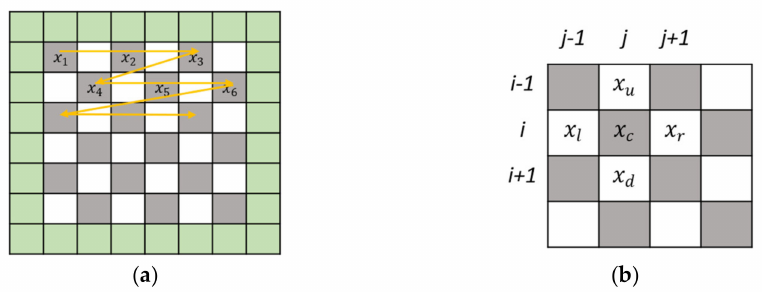
Figure 1. Image scanning and embedding mode. ( a ) a zig-zag scan ( b ) the gray pixel x c and its surrounding four white